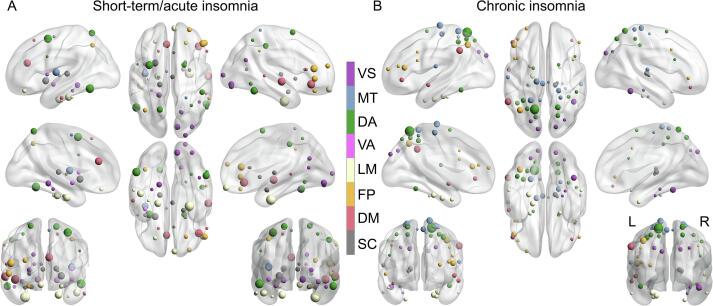
The regions with the highest absolute contribution weight in the PSQI prediction model in both (A) short-term/acute and (B) chronic insomnia groups. The 50 regions with the highest absolute contribution weight are displayed, with the colour representing the different cognitive systems. VS: visual; MT: motor; DA: dorsal attention; LM: limbic; FP: fronto-parietal; DM: default mode; SC: subcortical.